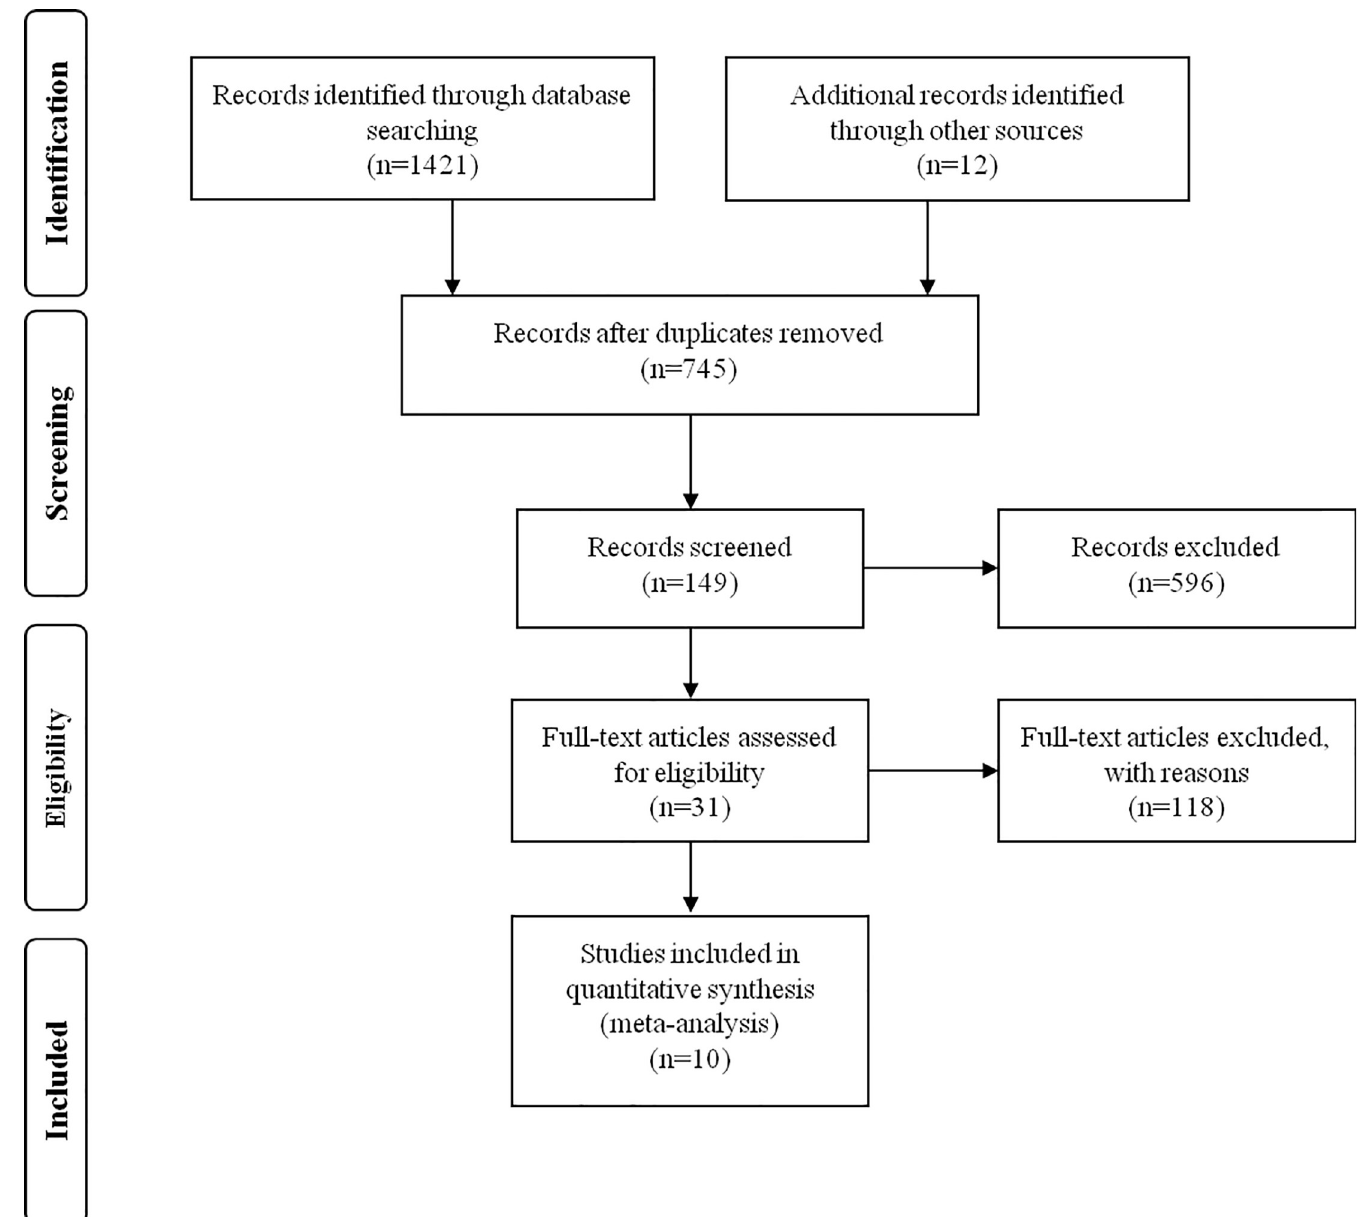
Fig 1. A flowchart presenting the steps of literature retrieval and